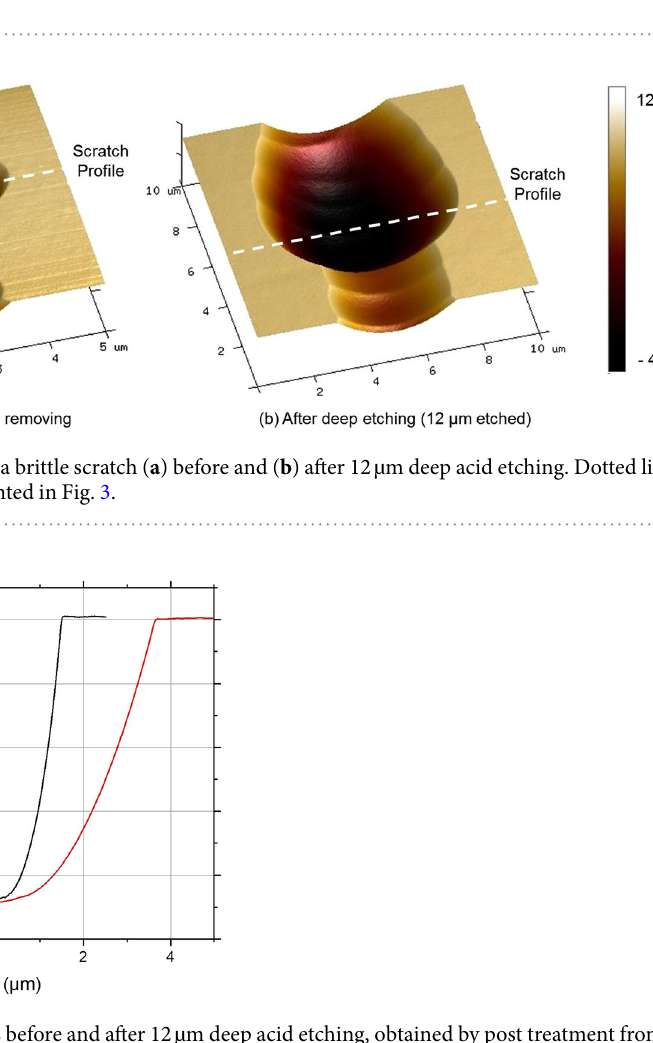
Figure 1. Optical microscope observations of brittle and plastic scratches ( a ) before and ( b ) after 12 µ m deep acid etching.